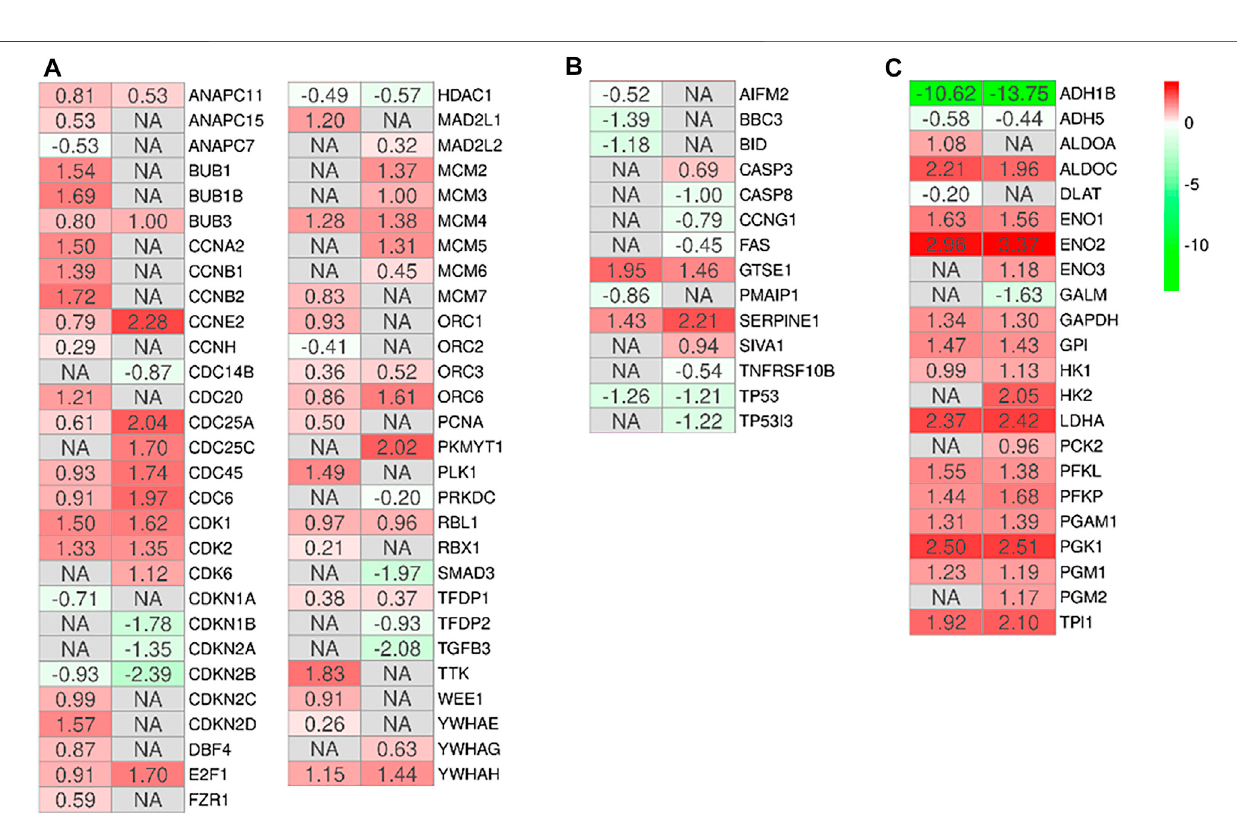
Frontiers in Bioengineering and Biotechnology |